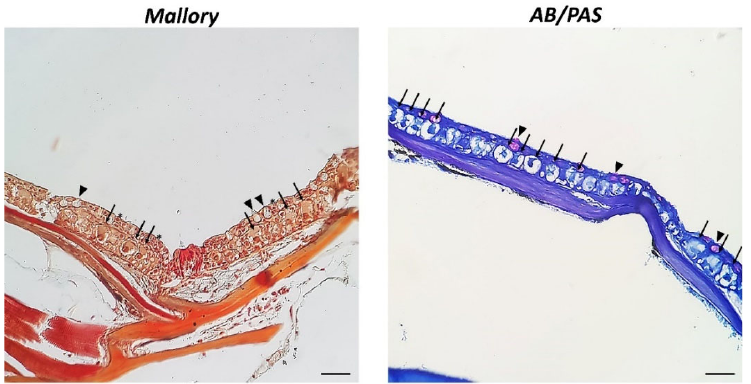
Figure 1. Cross sections (5 μ m thick) of the zebrafish skin, 40×, scale bar 40 μ m. These sections were stained with Mallory and AB/PAS. Mallory staining highlighted rounded, oval, and elongated CCs (arrows) in the intermediate layer of the epidermis with central acidophilic cytoplasm and spherical basophilic nucleus. Keratinocytes (*) are evident in the superficial stratum. The mucous cells (arrowheads) are located mainly in the superficial and medium layers, AB/PAS positive and appear purple, while CCs are AB/PAS negative, with a dark central nucleus. By immunoperoxidase, CCs were positive for TLR2, Piscidin1, and MAPK p38 (Figures 2 and 3). Counter ‐ staining with H of a section treated with immunoperoxidase for MAPK p38 clearly highlights immunoreactive CCs with keratinocytes and mucous cells in the outer epidermal layer in the surrounding tissue.